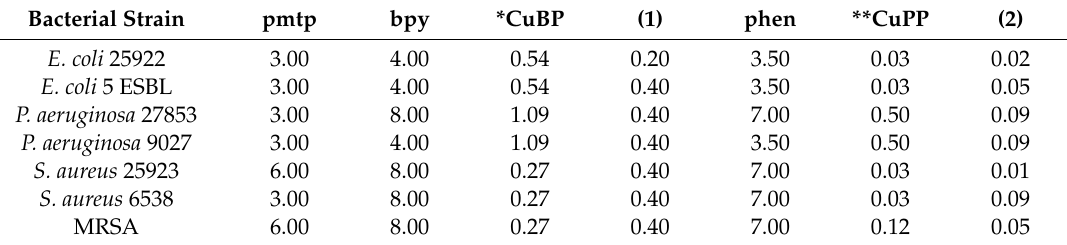
Table 3. The MIC values (mM) for ligand and